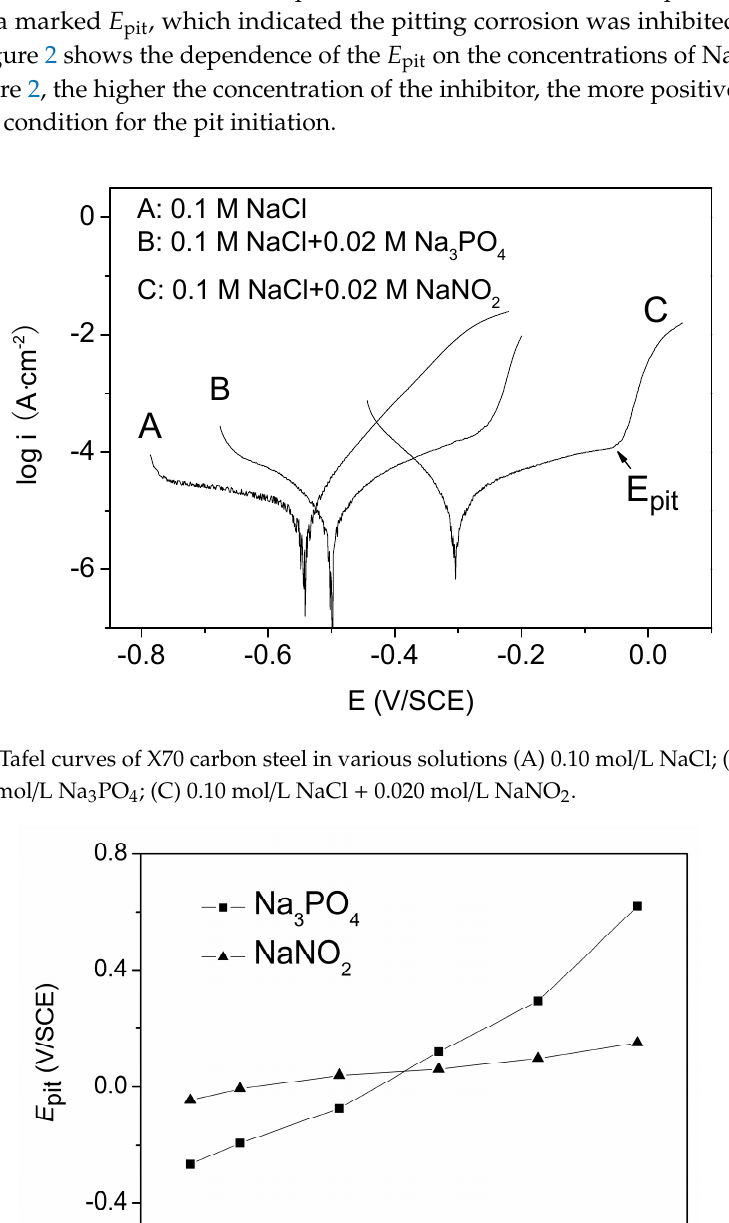
Figure 3. The SECM images of the X70 carbon steel electrode polarized at − 0.320 V ( E OCP = − 0.570 V) in 0.10 mol/L NaCl solution ( A ) 10 min; ( B ) 20 min; ( C ) 30 min. 3.3. The Pitting Corrosion of X70 Carbon Steel in the NaCl Solution with Na 3 PO 4 When there was Na 3 PO 4 in the NaCl solution, the SECM images were completely different. Figure 5 shows the processes of the pitting corrosion of the specimens at E S = − 0.290 V (the E OCP is about − 0.540 V) in 0.10 mol/L NaCl solution containing various concentrations of Na 3 PO 4 . As shown in Figure 5A1–E1), two current peaks at the 10th min (A1) and three current peaks at the 20th min (B1) were observed on the surface of the specimen in the solution with 0.020 mol/L Na 3 PO 4 . Then, one current peak disappeared; the other two current peaks propagated while another two current peaks emerged (C1). And several pits initiated (D1) and developed to stable pits (E1) after 50 min anodic polarization. The current peak at the 20th min (point “a” in B1) disappeared at the 30th min, and it did not reappear anymore. The current peaks (point “b” and “c” in B1) at the 20th min developed to stable pits and did not disappear all along. One current peak appeared at the 20th min (B2) and two current peaks were observed at the 30th min (C2) in the NaCl solution containing 0.040 mol/L Na 3 PO 4 , while only one current peak occurred at the 30th min in the NaCl solution containing